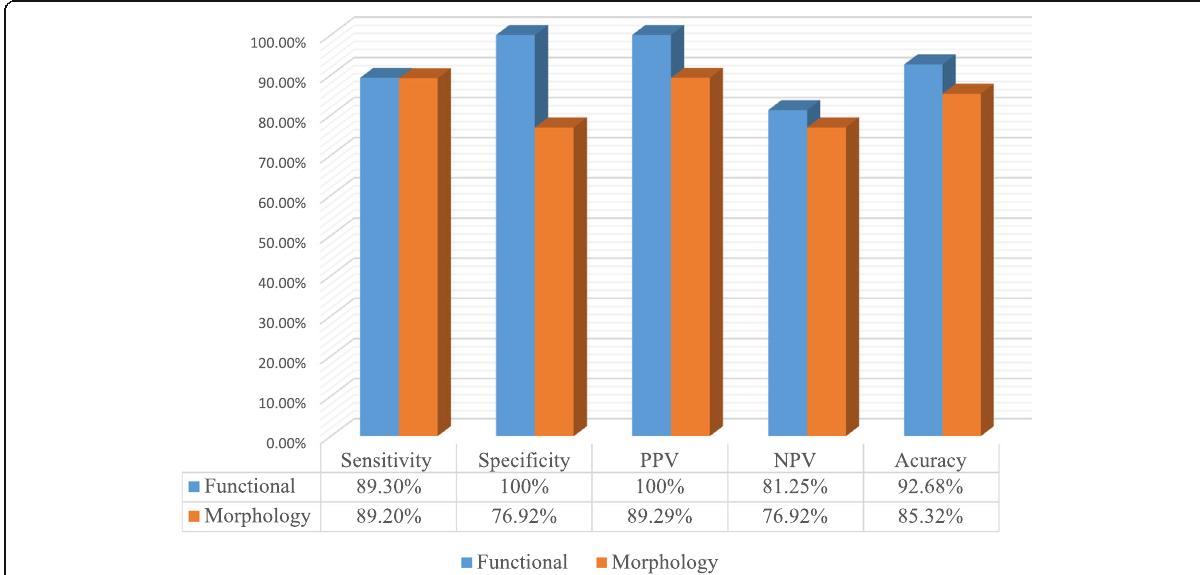
Fig. 6 A chart comparing the results of morphological and functional MRI assessment to differentiate benign from malignant pleural